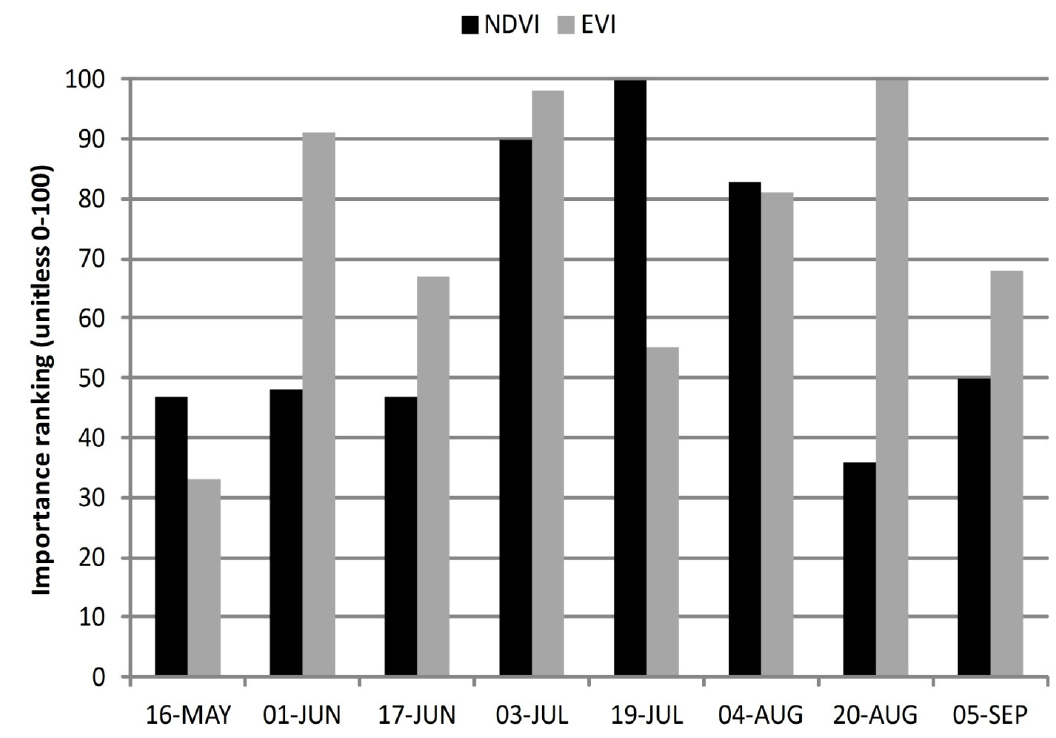
Figure 11. Variable importance for the best case classification of the first difference series